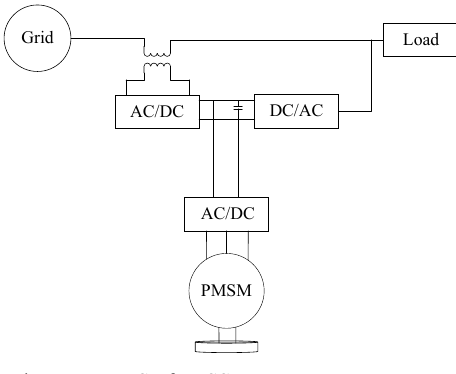
Fig. 10. The Online Interactive Type UPS of FESS.